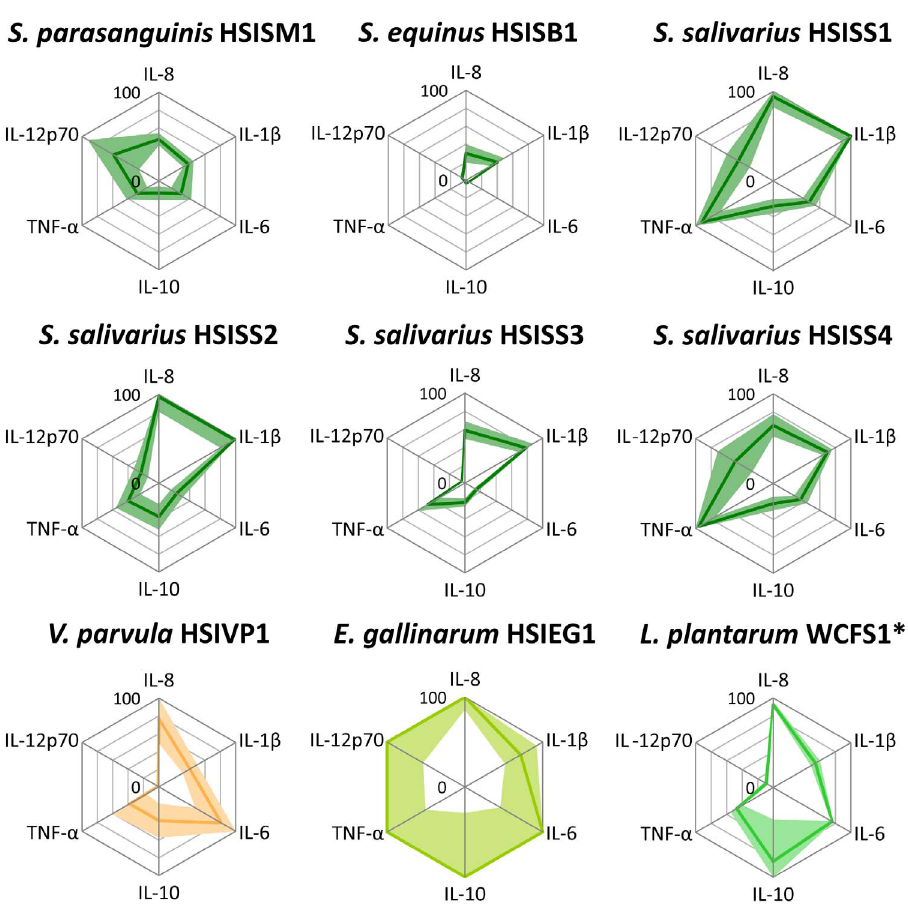
Figure 2. Cytokine secretion by dendritic cells after stimulation with bacterial strains. Dendritic cells were derived from monocytes of 5 human different donors. Cytokine levels are expressed as relative values of the highest inducing strain (100% cytokine levels (pg/ml): IL-8: 17598; IL-1 b : 41; IL-6: 4775; IL-10: 206; TNF- a : 5151; IL-12p70: 2397; Table S2). Lines represents the average secreted cytokine amounts and faded colours represent the interval between the upper and the lower SEM. SEM values higher than 100% are not visualized. *: Cytokine responses determined using DCs derived from 2 different human donors (Figure 5, Table